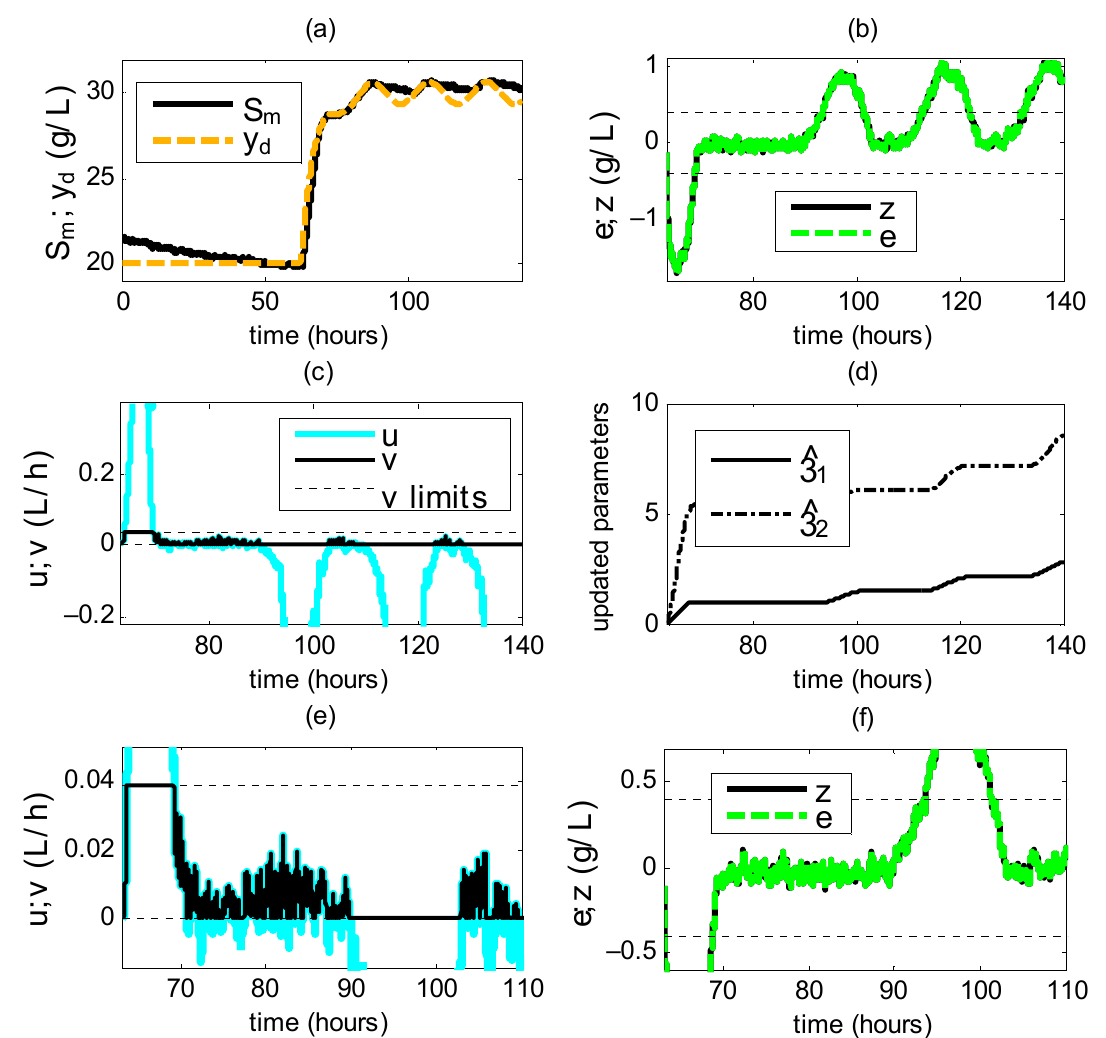
Figure 4. Simulation results for the third simulation case. ( a ) Time course of the measured output S m and the desired output y d . ( b ) Time course of the tracking error e and the modified error z . ( c ) Time course of the non-saturated input u and the saturated input υ . ( d ) Time course of the updated parameters ˆ θ 1 , ˆ θ 2 . ( e ) Detail of non-saturated input u and the saturated input υ . ( f ) Detail of the tracking error e and the modified error z